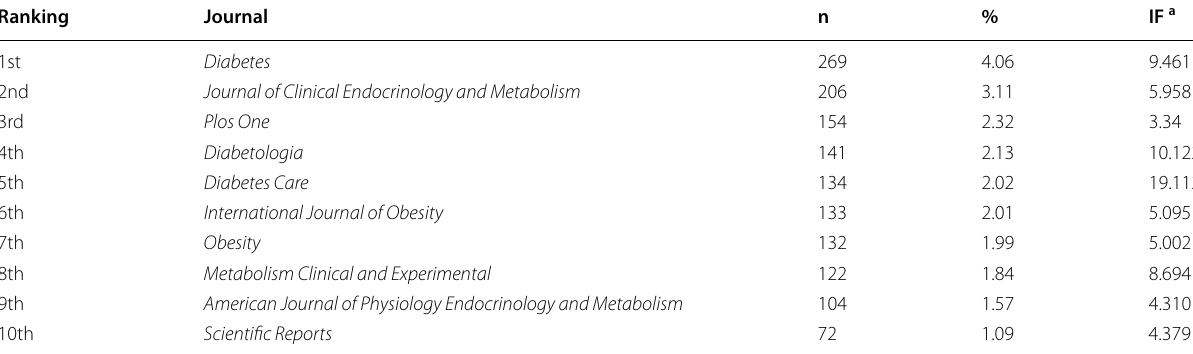
Table 3 A list of the top ten journals that published research on insulin resistance and obesity from 2002 to 2021